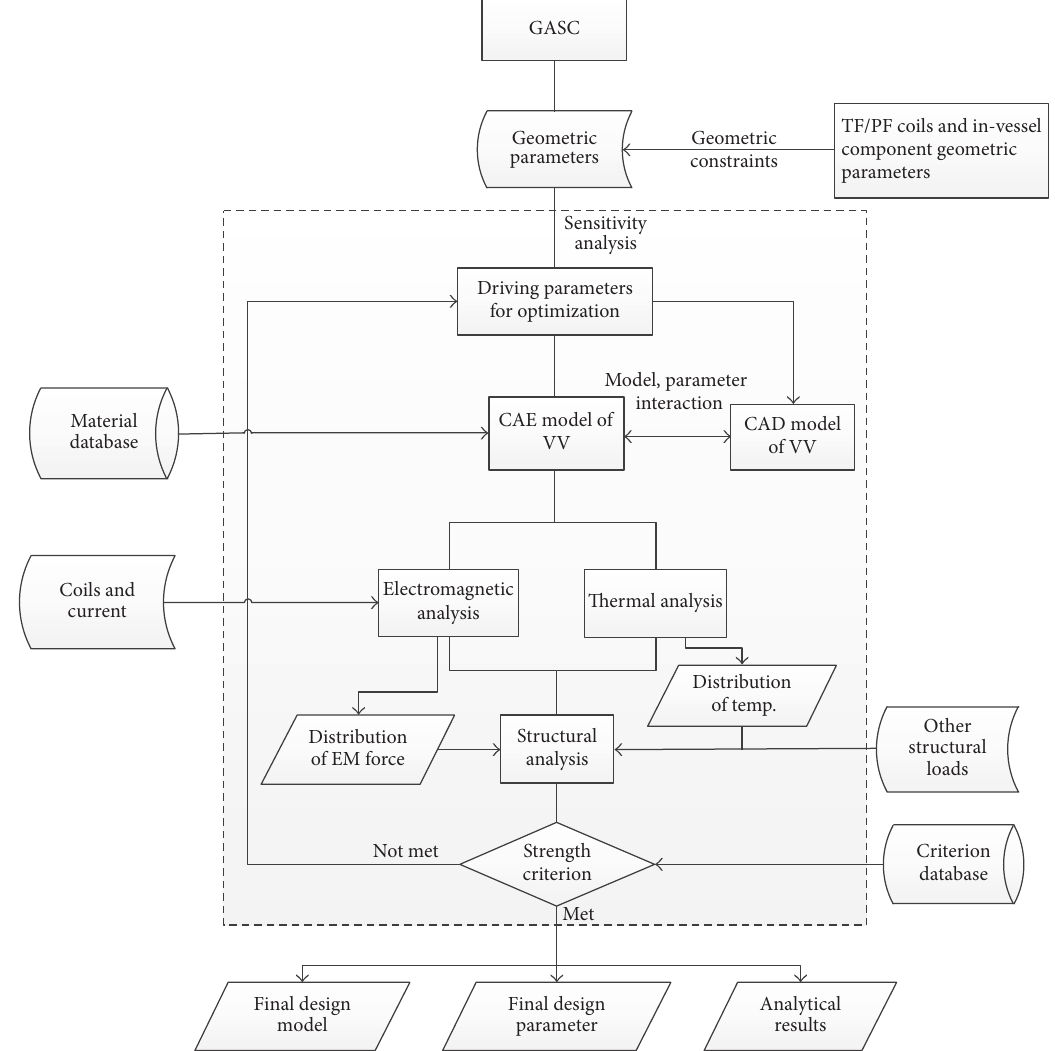
Figure 1: Conceptual workflow of VV